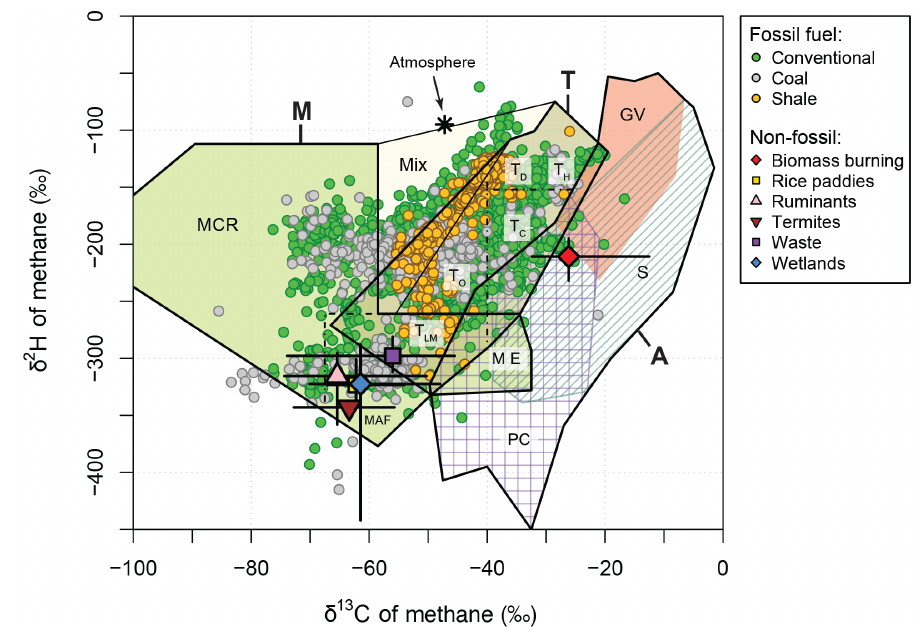
versus δ 13 C CH , redrawn from Etiope (2015), based on thermogenic fields by Hunt (1996) Figure 6. Genetic characterization plot of δ 2 H CH 4 4 and Milkov (2011) and abiotic gas from Etiope and Sherwood Lollar (2013) and Etiope and Schoell (2014). The reversed vertical and horizontal axes as compared to Fig. 5 follow conventions established previously to emphasize abiotic fields. M: microbial; T: thermogenic; A: abiotic; MCR: microbial CO 2 reduction; MAF: microbial acetate fermentation; ME: microbial in evaporitic environment; T O : thermogenic with oil; T C : thermogenic with condensate; T D : dry thermogenic; T H : thermogenic with high-temperature CO 2 –CH 4 equilibration; T LM : thermogenic low maturity; GV: geothermal–volcanic systems; S: serpentinized ultramafic rocks; PC: Precambrian crystalline